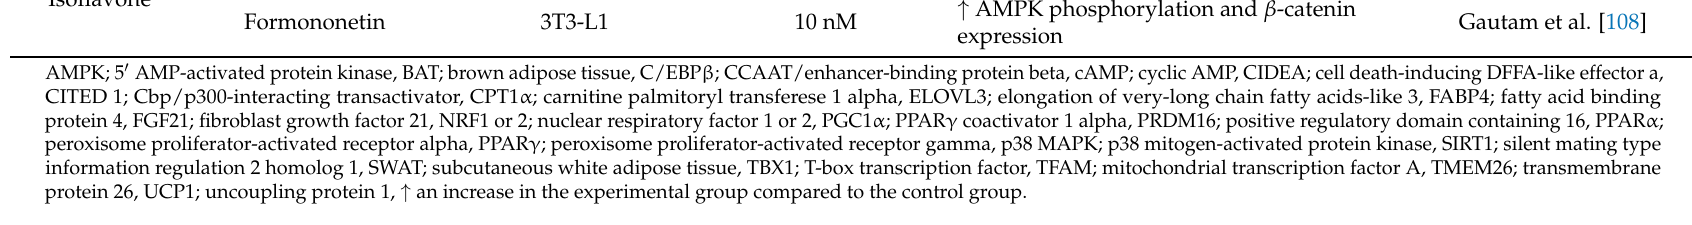
Table 3. In vivo evidence for the increase of non-shivering thermogenesis by